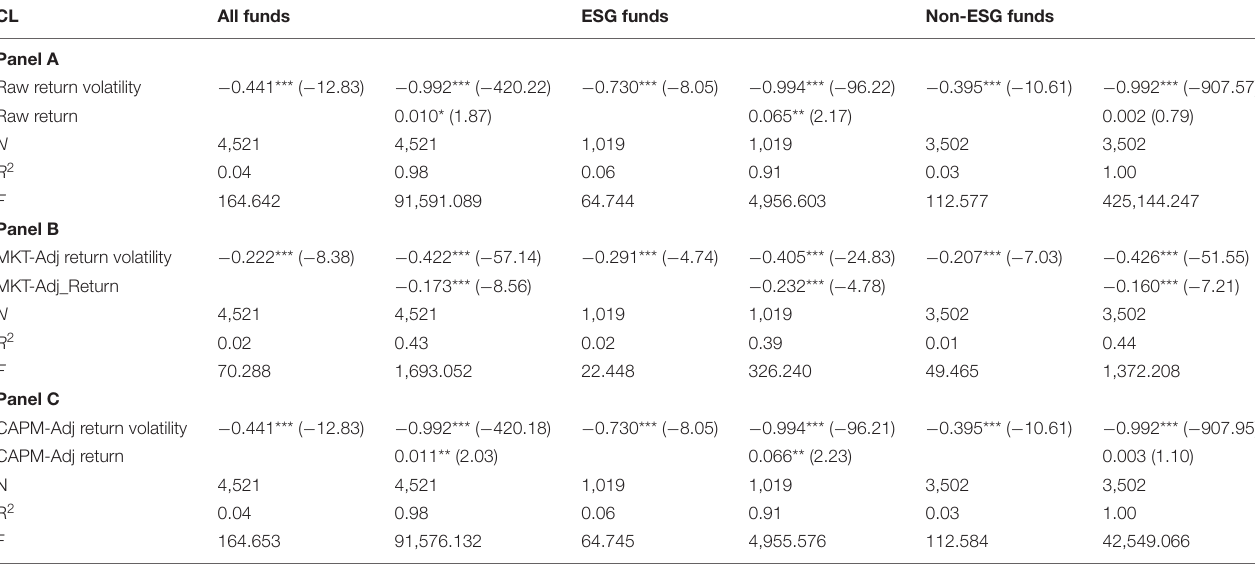
Table 5 is the result of comparing fund flow–performance volatility sensitivity. The dependent variable is fund flow. Raw return is the average of returns over the previous 12 months; MKT-Adj return, the market-adjusted returns over the previous 12 months; CAPM-Adj return, CAPM-adjusted return over the previous 12 months; Raw return volatility, the volatility of raw return over the previous 12 months; MKT-Adj return volatility, the volatility of the market-adjusted returns over the previous 12 months; CAPM-Adj return volatility, the volatility of CAPM-adjusted returns over the previous 12 months; The content of the table is the regression coefficient value; the figure in parentheses, t-value; and ***, **, and * means that each is significant, respectively, at 1, 5, and 10%. TABLE 6 | Fund flow–performance volatility sensitivity.